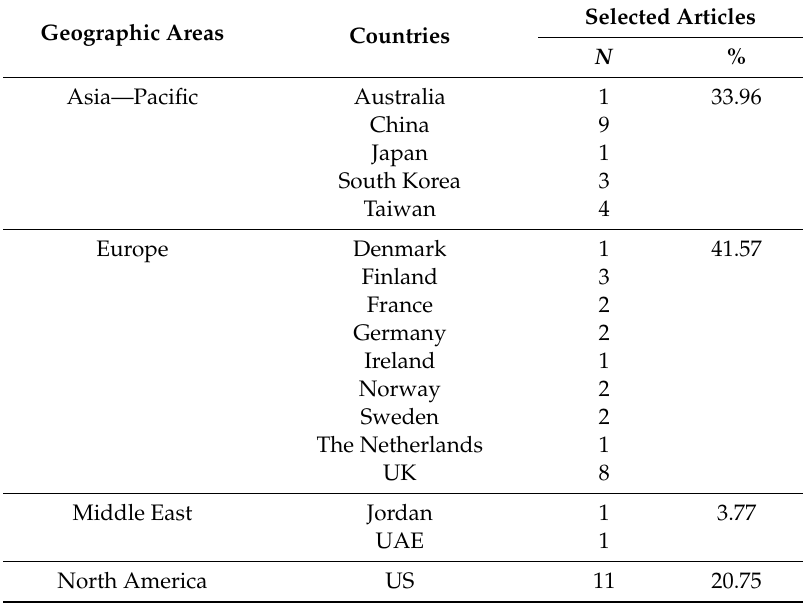
Table 3. Numbers and percentages of publications’ geographic